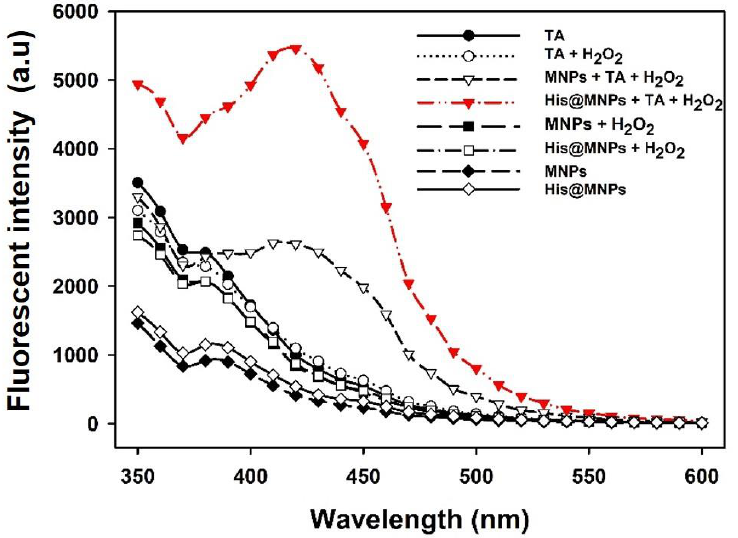
Figure 4. Fluorescence spectra for detecting free hydroxyl ( · OH) radicals produced during the peroxidase-mediated decomposition of H 2 O 2 , utilizing TA as a probe.